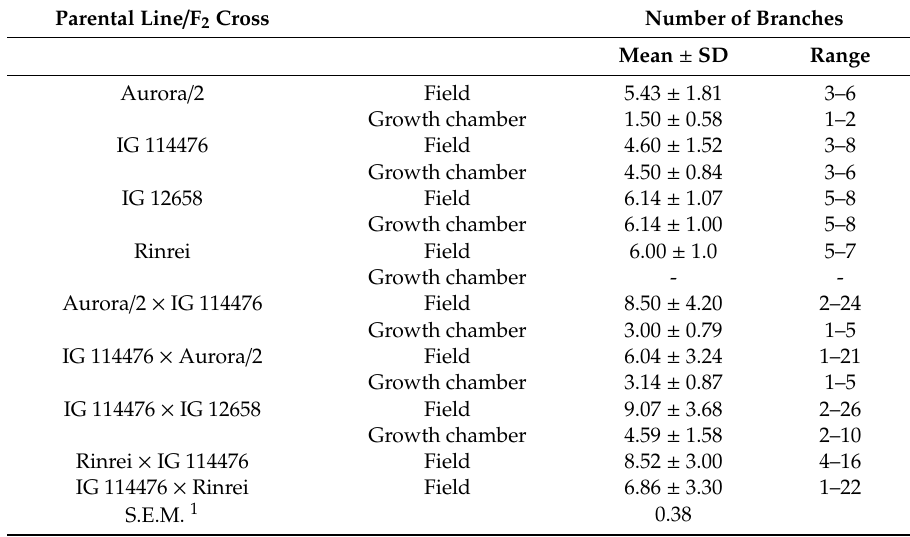
Table 4. The mean ± standard deviation (SD) and the range for the number of branches under the field and growth chamber conditions of parent lines and F 2 faba bean